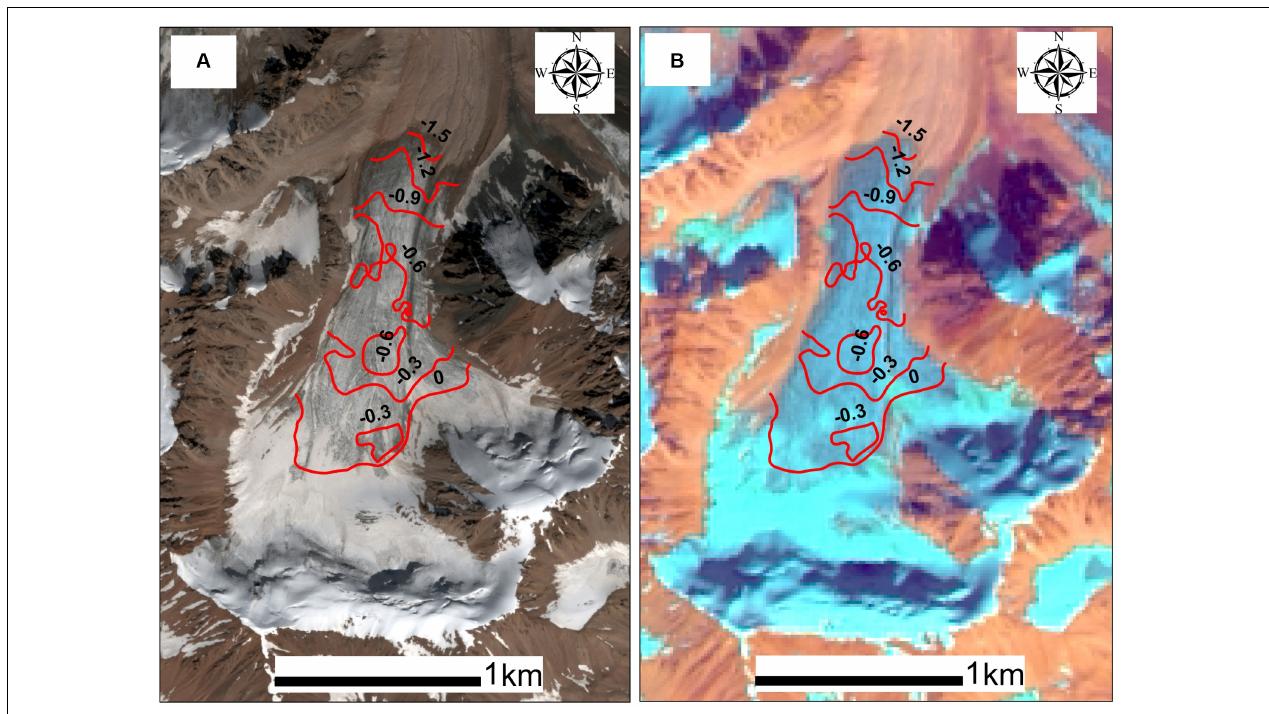
FIGURE 2 | Extent of snow cover on the (A) Pléiades image of 27 August 2016 and (B) Landsat 8 image of 22 September 2016. Isolines show ice ablation (m w.e.) as measured by the stake method on 24 September 2016. Note that the position of the snow line has not changed significantly between 27 August and the end of the mass balance year in